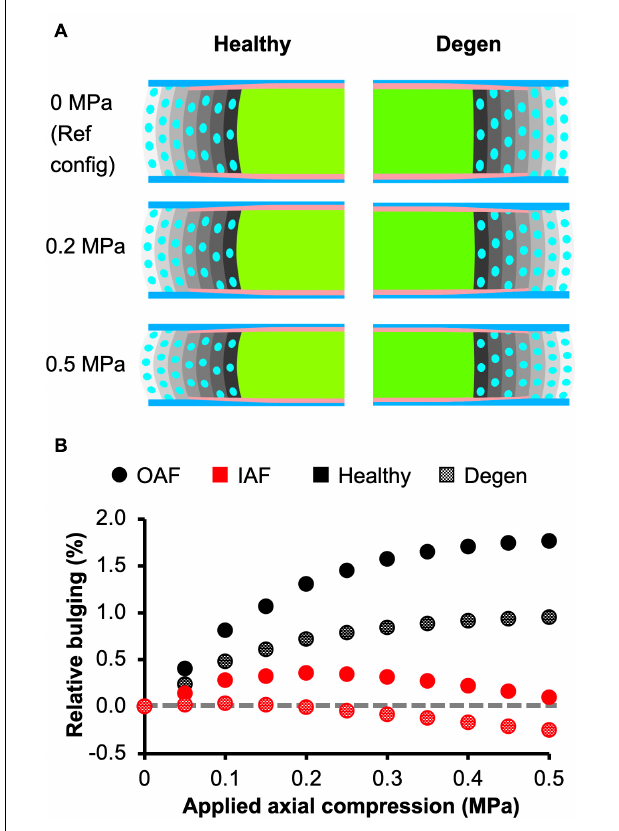
FIGURE 9 | (A) Disc mid-frontal (or coronal) cross sections demonstrating the relative annulus fibrosus (AF) bulging in healthy and degenerated (Degen) disc models under axial compression. The relative AF bulging was calculated using the post-swelling 0 MPa configuration as the reference configuration (Ref config). (B) Relative bulging in the inner and outer AF in healthy and degenerated disc models. Positive and negative relative bulging suggest outward and inward AF bulging compared to the reference configuration, respectively. The gray horizontal dashed line represents the relative disc bulging threshold, below which the AF was predicted to bulge inward compared to the reference